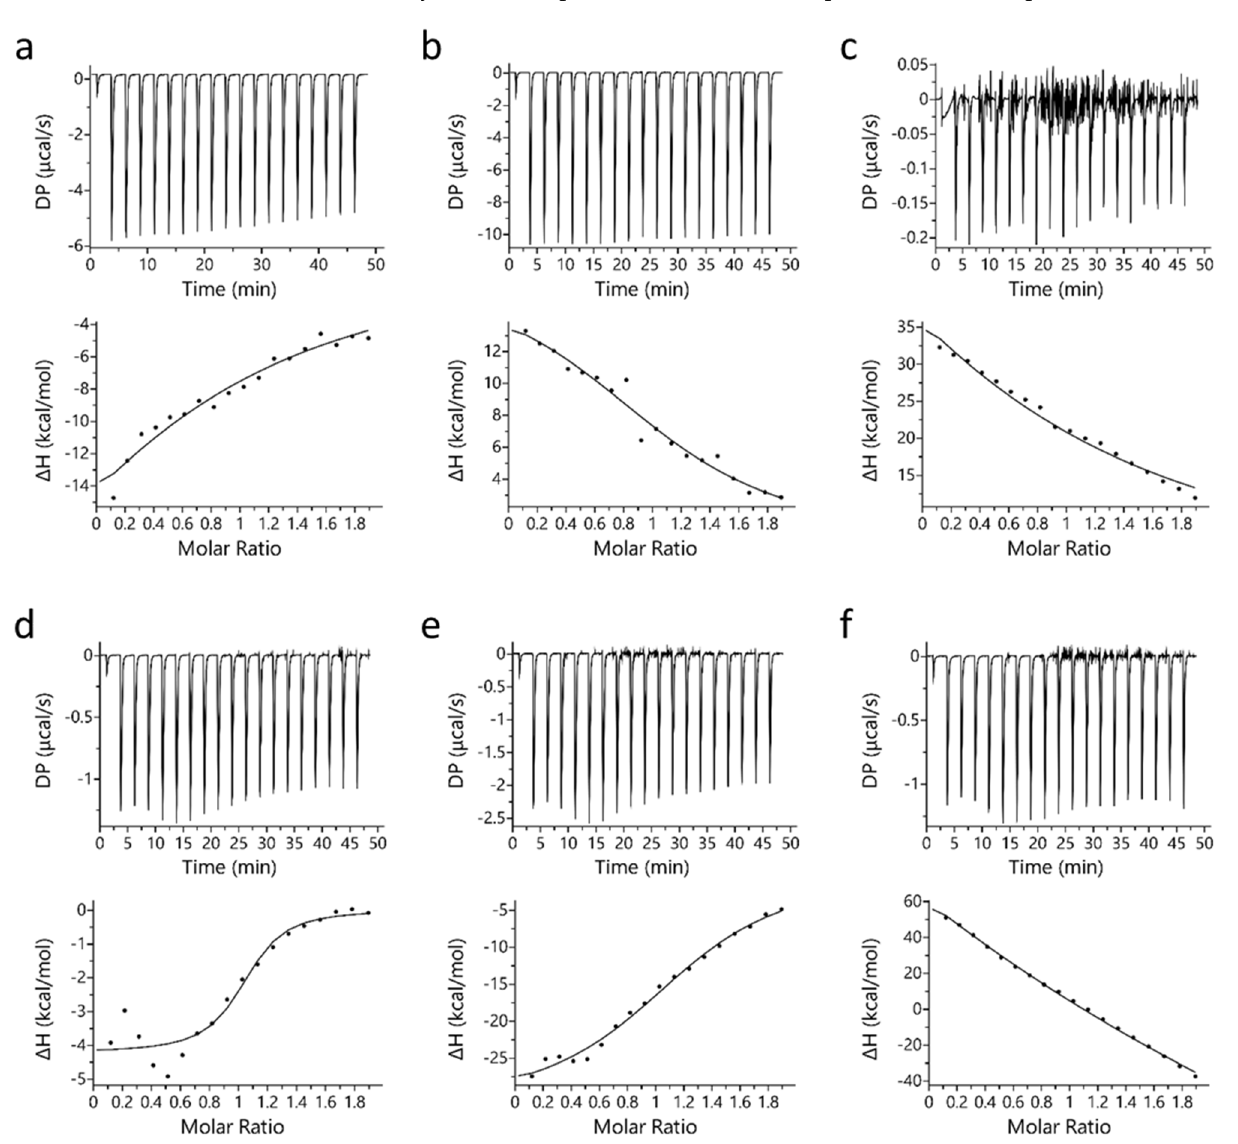
protein is changed [33] and this could be one of the possible reason for the observed dif- ference in interaction of Mb and PYR at neutral and acidic pH. ITC studies also revealed the binding affinity ( K a , inverse of K d ) of PYR interaction with oxy- and deoxy-Mb in different pH conditions. Specifically, with a drop in pH, the K a of PYR for deoxy-Mb was decreased by ~7-fold (at pH 6.4) and ~60-fold (at pH 6.0) relative to pH 7.0 value (Table 1).